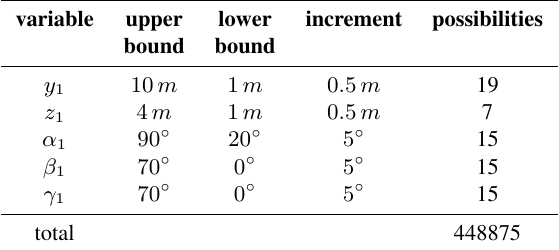
Table 3. Bounds and increments of the variables